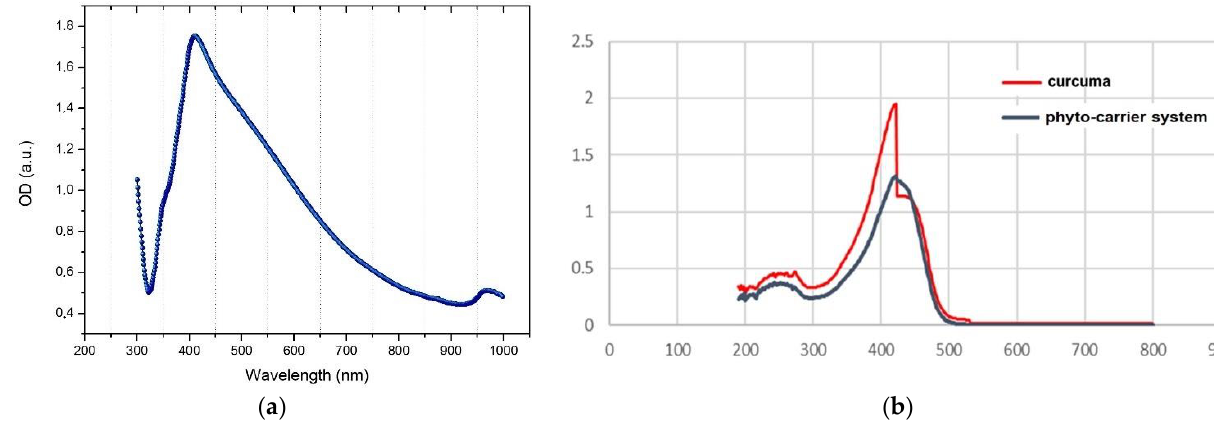
Figure 6. ( a ) UV-Vis spectra of citrate-coated AgNPs; ( b ) UV-Vis spectra of the phytocarrier system and curcuma sample.